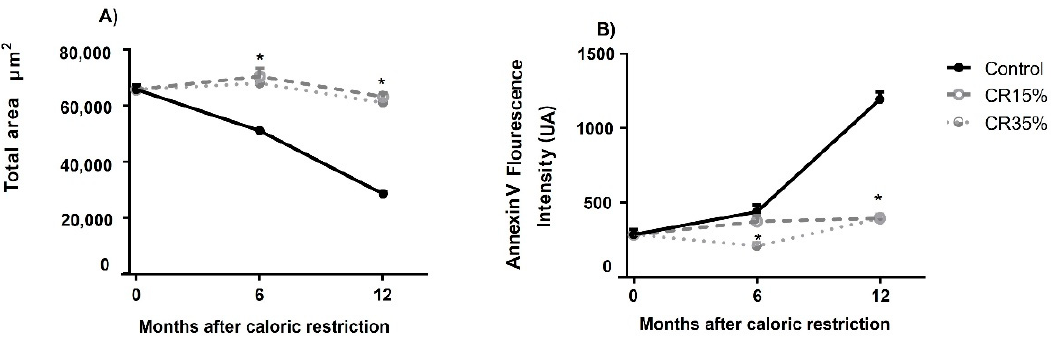
Figure 3. Effect of CR on the total area and apoptosis of testicular tubules in aged male Wistar rats. The values obtained show mean ± SE of the total area of the seminiferous epithelium tubules ( A ) and the fluorescence intensity of the protein annexin V as a pre-apoptotic marker in seminiferous epithelium tubules ( B ) in rats with CR at 15% and 35% for 6 and 12 months of CR. * Indicates significant differences between the CR 15% and 35% vs. the control group, p < 0.01.